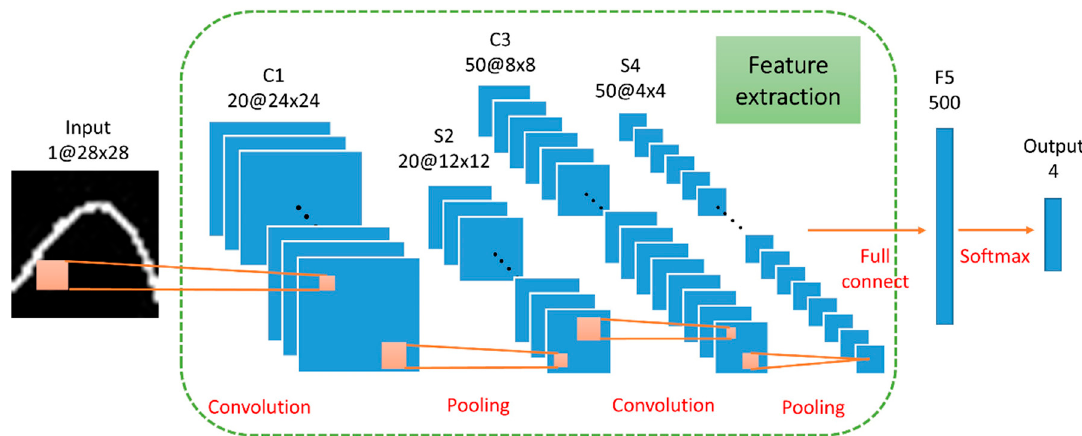
Figure 5. Main architecture of convolutional neural network (CNN).